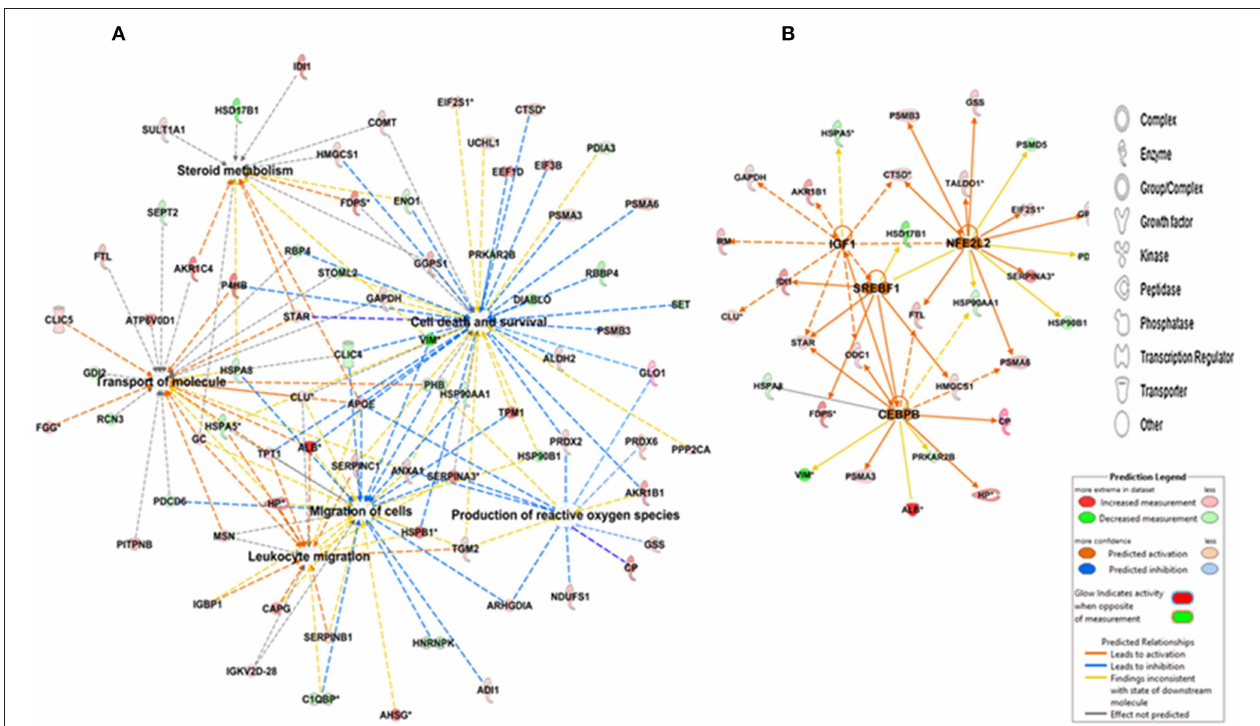
TABLE 2 | IPA analysis overview: canonical pathways and molecular and cellular functions associated with differentially regulated proteins between POFs and the CL. P -value No. of molecules Canonical pathways P -value No. of molecules Top molecular and cellular functions Cell death and survival 1.46E-10 45 Acute phase response signaling 8.39E-07 9 2.19E-06 4 Steroid metabolism 6.21E-09 14 Super pathway of geranylgeranyldiphosphate biosynthesis (via mevalonate) Cellular movement 6.54E-07 39 Superpathway of cholesterol biosynthesis 1.80E-05 4 Molecular transport 7.09E-06 27 RhoA signaling Free radical scavenging 2.52E-05 LXR/RXR